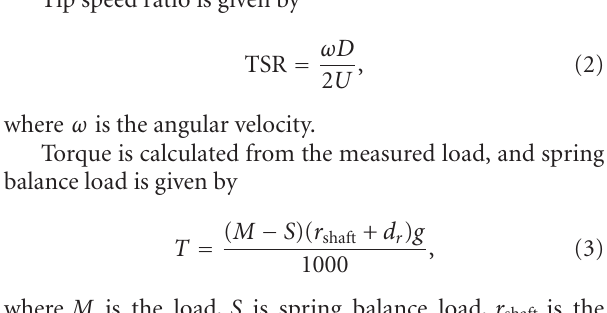
where Re is Reynolds number, ρ is the density of water, U is the free stream velocity, D is the rotor diameter, and μ is the absolute viscosity of